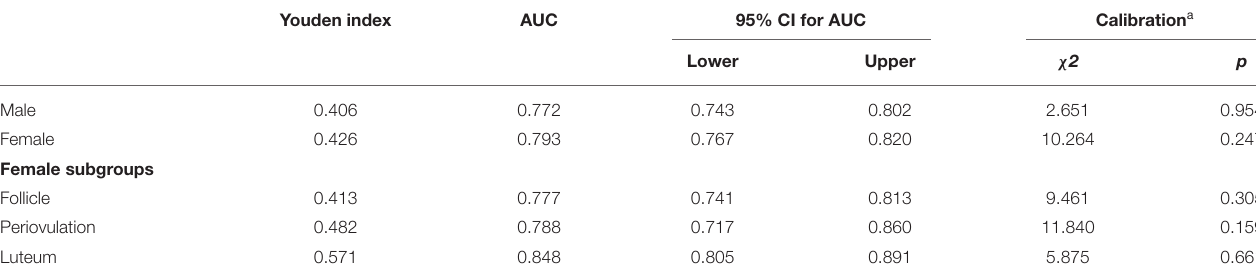
TABLE 3 | Discrimination and calibration of the algorithm performance of biochemical index and HPT axis by BD/MDD diagnoses. Youden index AUC 95% CI for AUC Calibration a Lower